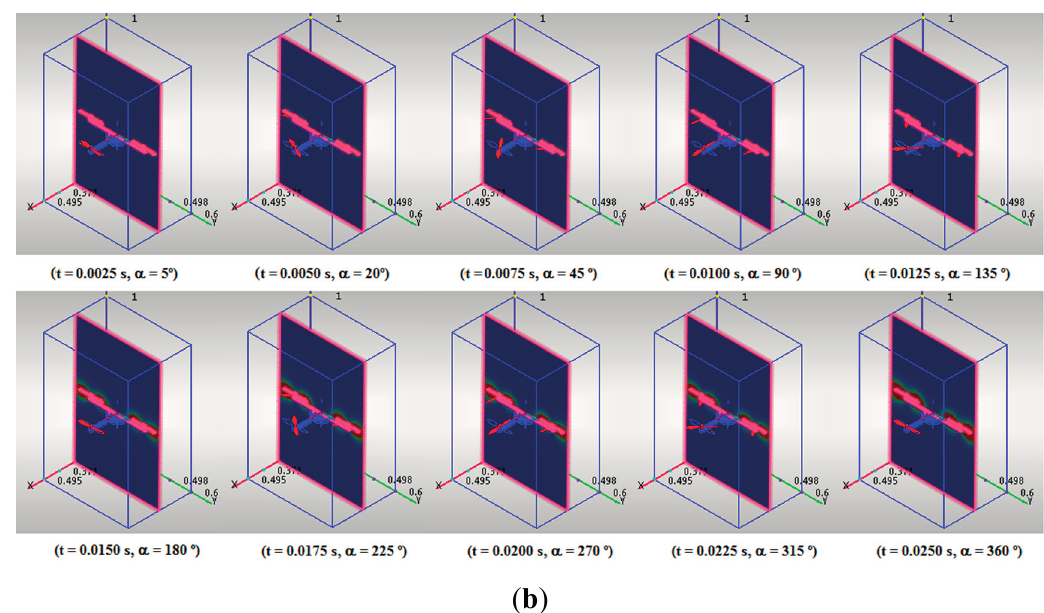
Figure 5. ( a ) Airspeed profile in the horizontal plane; ( b ) Airspeed profile in the vertical plane.